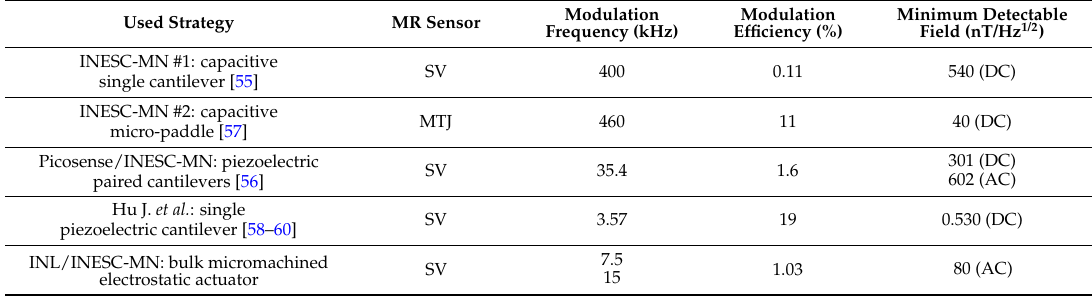
Table 2. Comparison of the different proposed hybrid devices integrating MR sensors with MEMS flux concentrators regarding the modulation efficiency and minimum detectable